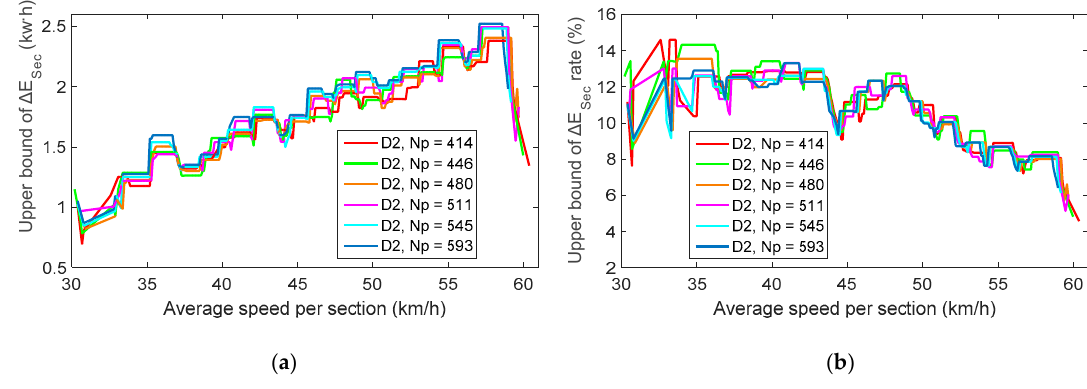
Figure 21. Comparison of upper boundaries with different N p values (weekend, TQ-SH). ( a ) ASS-REN-PLF boundaries; ( b ) ASS-RER-PLF boundaries.